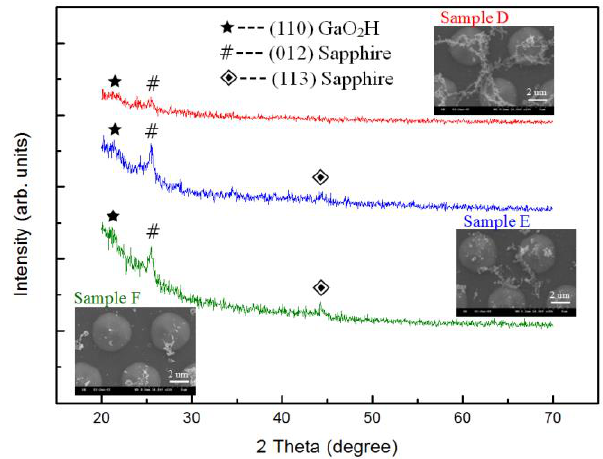
Figure 4. XRD spectra of GaN-epi/PSSs prepared by using substrate-reclamation process II.